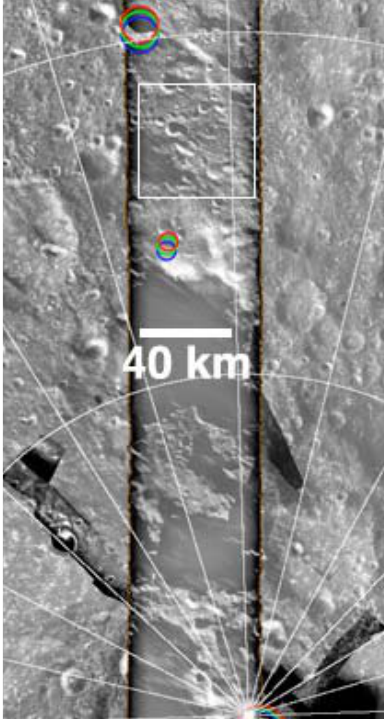
Figure 1. Overlay of LRO Mini-RF bistatic image of Cabeus crater (center) and environs on a mosaic of east-looking monostatic images. Circles show the misalignment of corresponding craters by several km between the uncontrolled east-looking (blue), west-looking (green) and bistatic (red) data products. Polar Stereographic projection, South Pole at bottom,